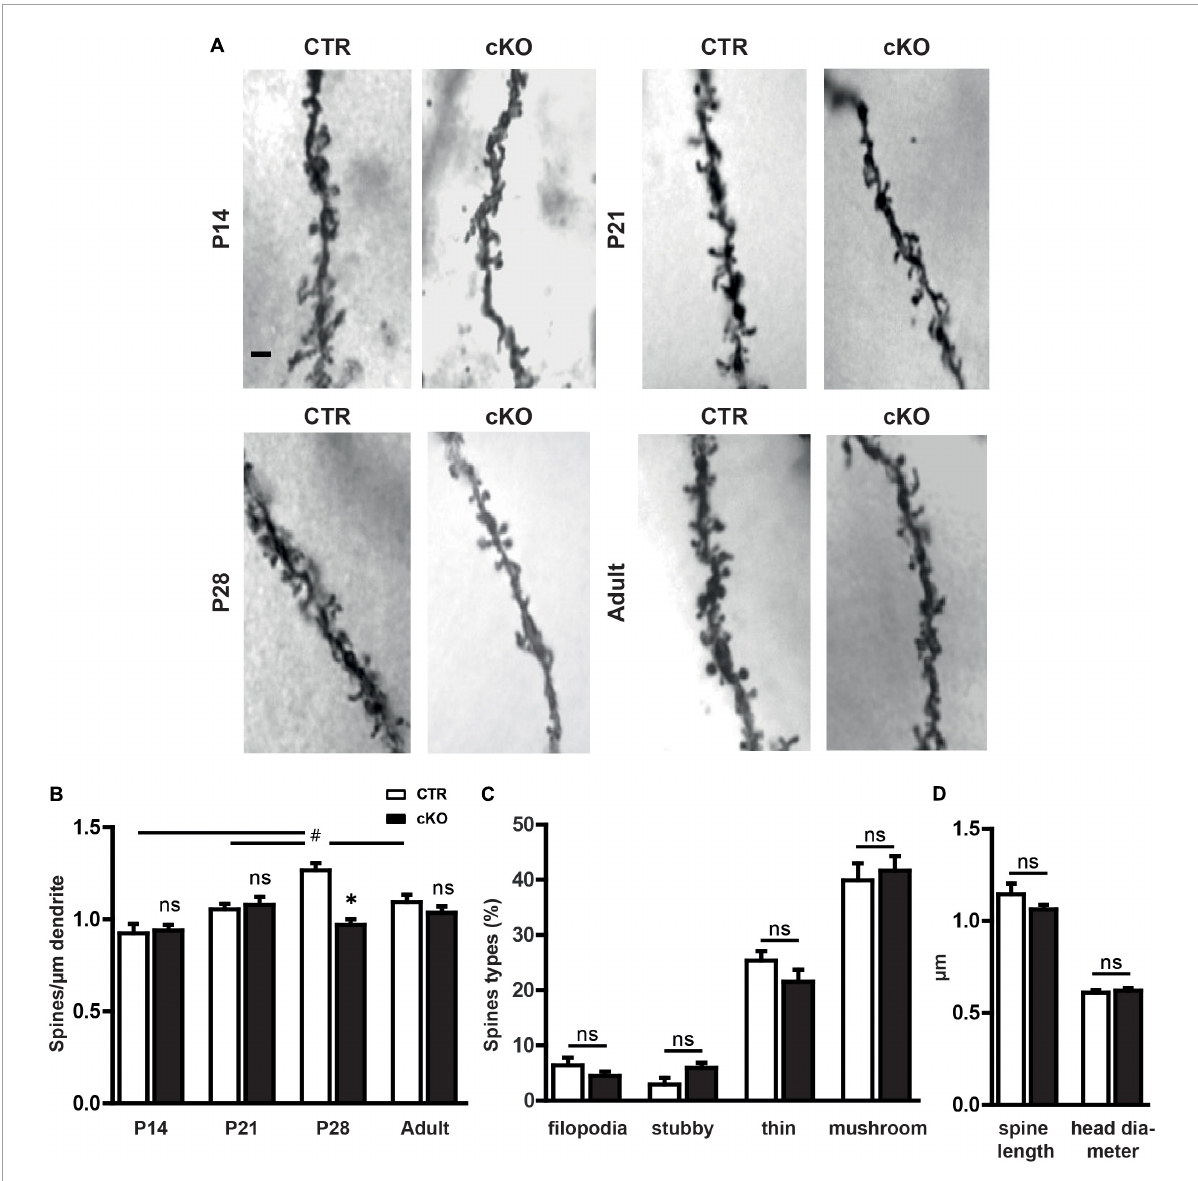
FIGURE1 Profilin1 is relevant for dendritic spine density during a specific period of postnatal development. (A) Representative micrographs of CA1 apical dendrites in Golgi-stained brain sections from CTR and cKO mice at different developmental stages. Scale bar: 1 µ m. (B) Quantification of total dendritic spine density at various postnatal stages; (spines/ µ m) P14: CTR: 0.92 ± 0.05, n = 3, cKO: 0.94 ± 0.03, n = 4, p > 0.99; P21: CTR: 1.05 ± 0.03, n = 4, cKO: 1.08 ± 0.04, n = 4, p > 0.99; p28: CTR: 1.30 ± 0.02, n = 4, cKO: 1.00 ± 0.03, n = 4, P < 0.05; adult: CTR: 1.10 ± 0.03, n = 4; cKO: 1.05 ± 0.04, n = 4. (C) Density of filopodia-like, thin, stubby, and mushroom-like spines in CTR and cKO mice at P28; (%) filopodia: CTR: 6.4 ± 1.4, cKO: 4.5 ± 0.8, p = 0.27; stubby: CTR: 2.9 ± 1.2, cKO: 6.0 ± 0.9, p = 0.09; thin: CTR: 25.4 ± 1.7, cKO: 21.5 ± 2.2, p =